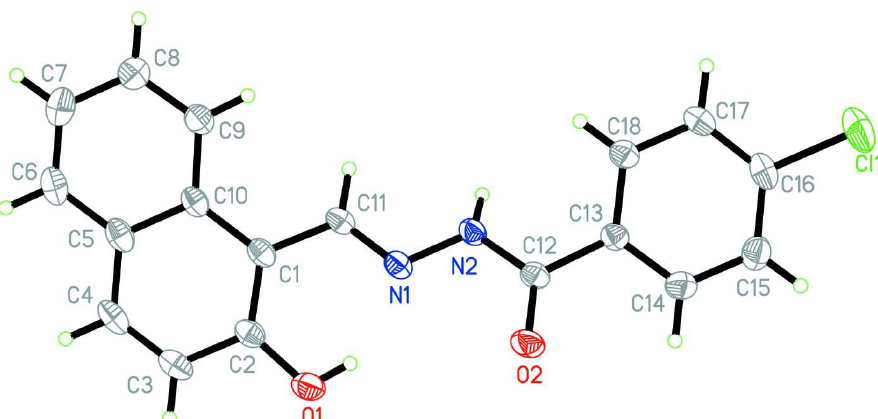
Figure 1 The molecular structure of the title compound, showing the atom-numbering scheme. Displacement ellipsoids are drawn at the 30% probability level.